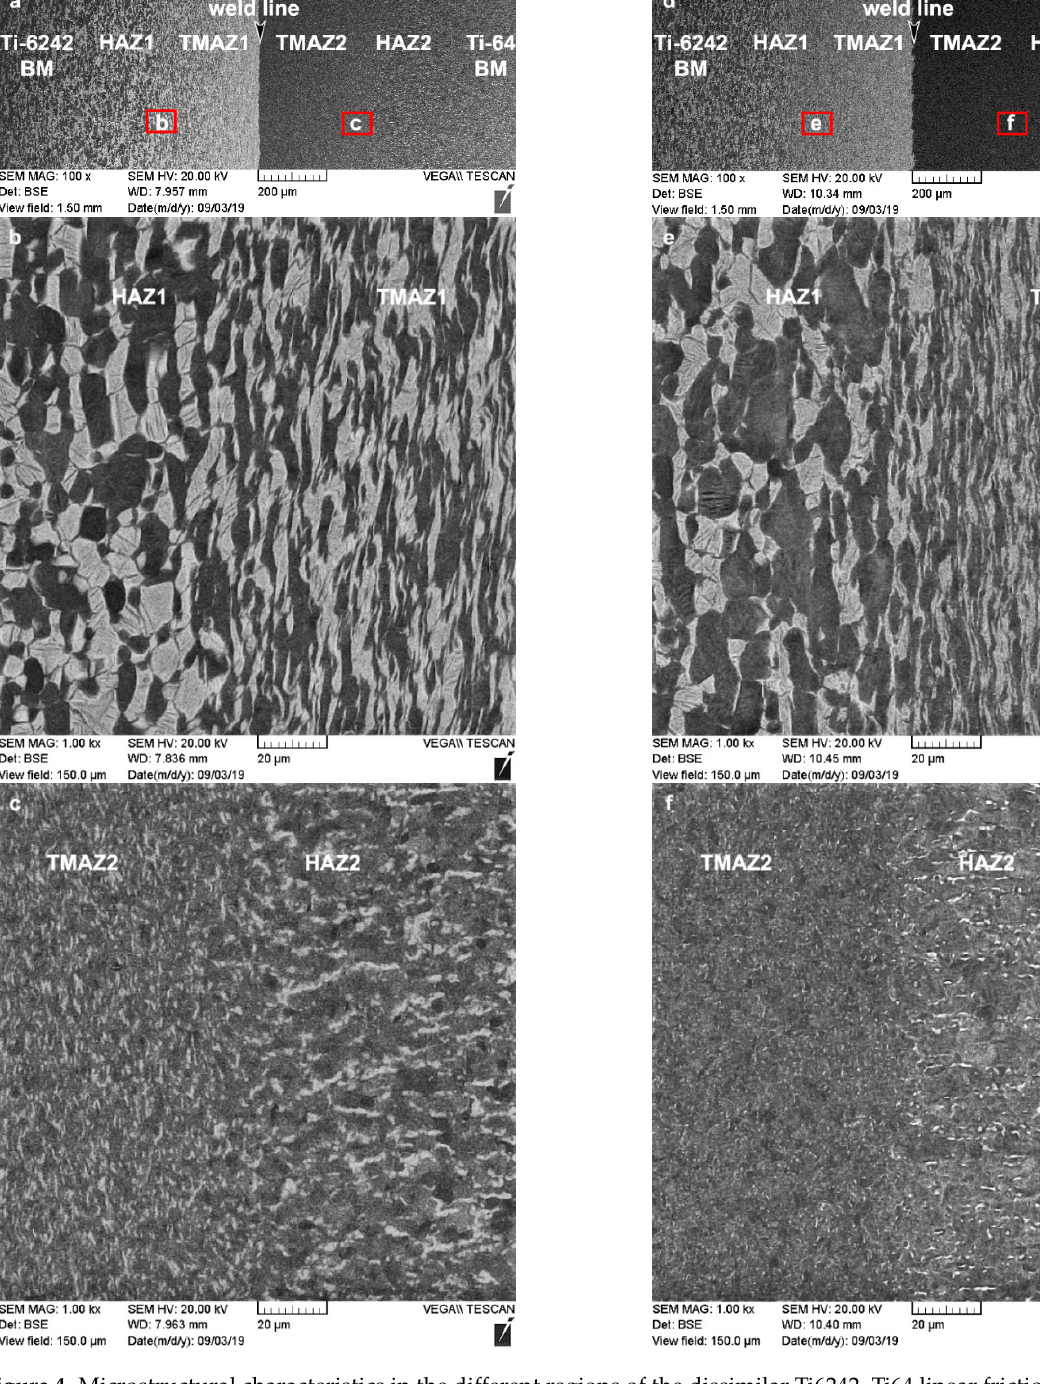
Figure 4. Microstructural characteristics in the different regions of the dissimilar Ti6242–Ti64 linear friction welds in the ( a – c ) AWed condition and ( d – f ) SRAed condition. Table 2. Comparison of the average hardness in the different regions of the dissimilar Ti6242–Ti64 weld in the AWed and SRAed conditions.